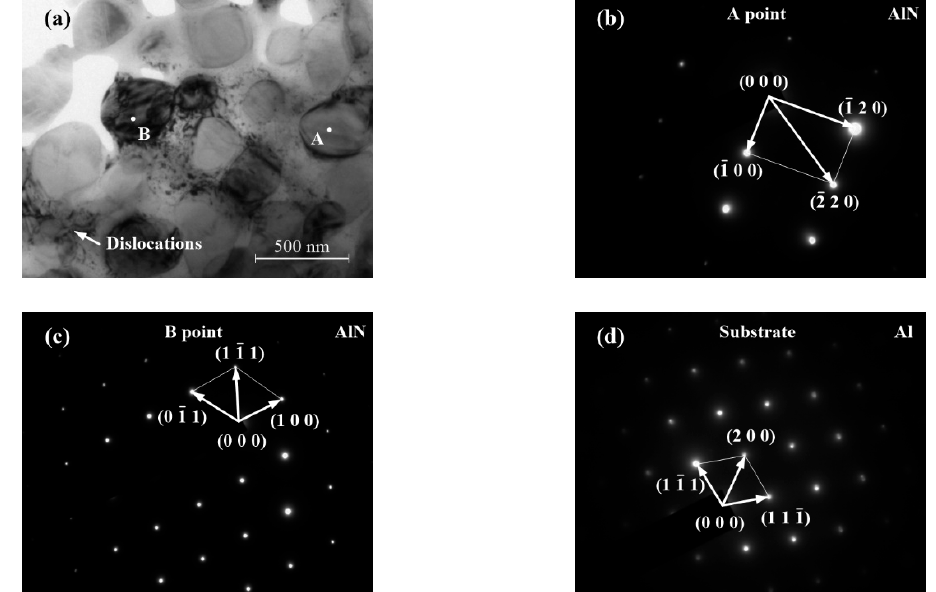
Figure 6. ( a ) TEM micrograph of the bottom part of AlN-1060. ( b ) Selected area electron diffraction (SAED) pattern of A point. ( c ) SAED pattern of B point. ( d ) SAED pattern of the substrate.